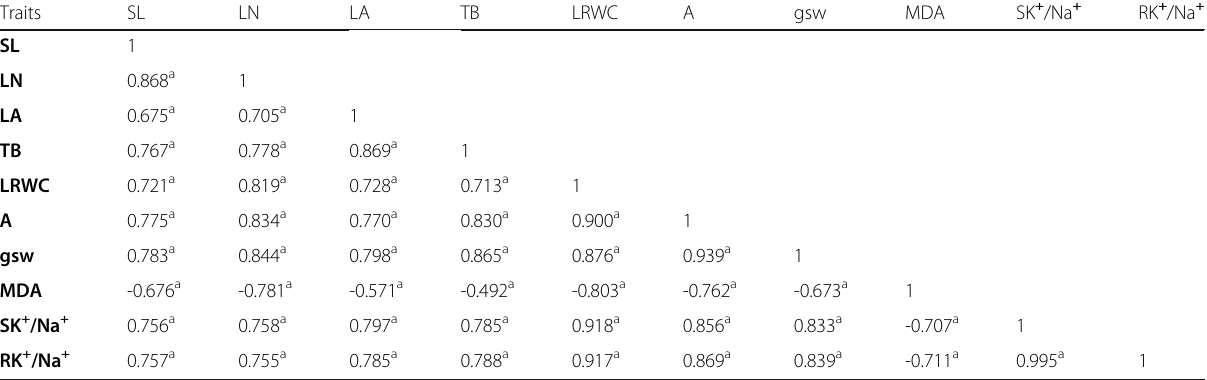
Table 3 Pearson ’ s correlation among different traits of cotton genotypes in the presence of 200 mmol·L -1 NaCl treatment